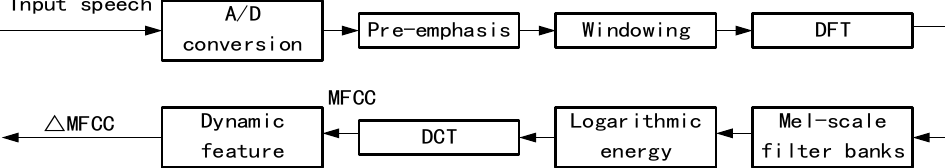
Figure 2. Flow chart of extracting Mel-Frequency Cepstral Coefficient (MFCC).